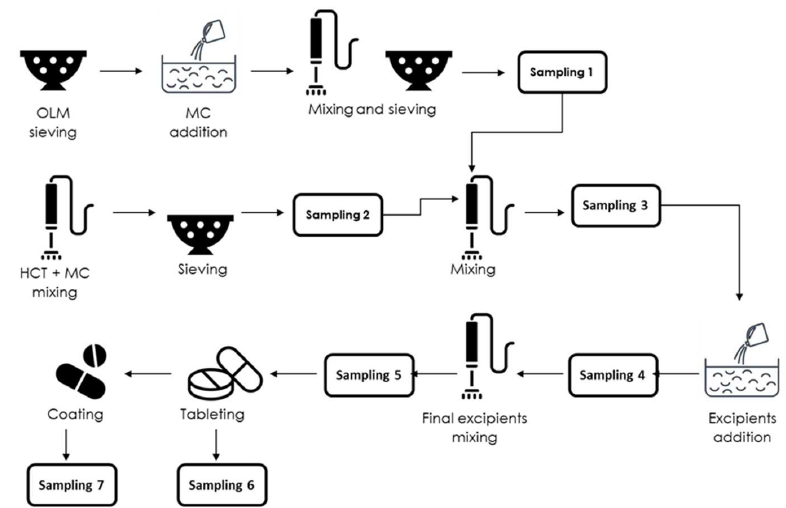
Figure 2. Schematic representation of the manufacturing process.